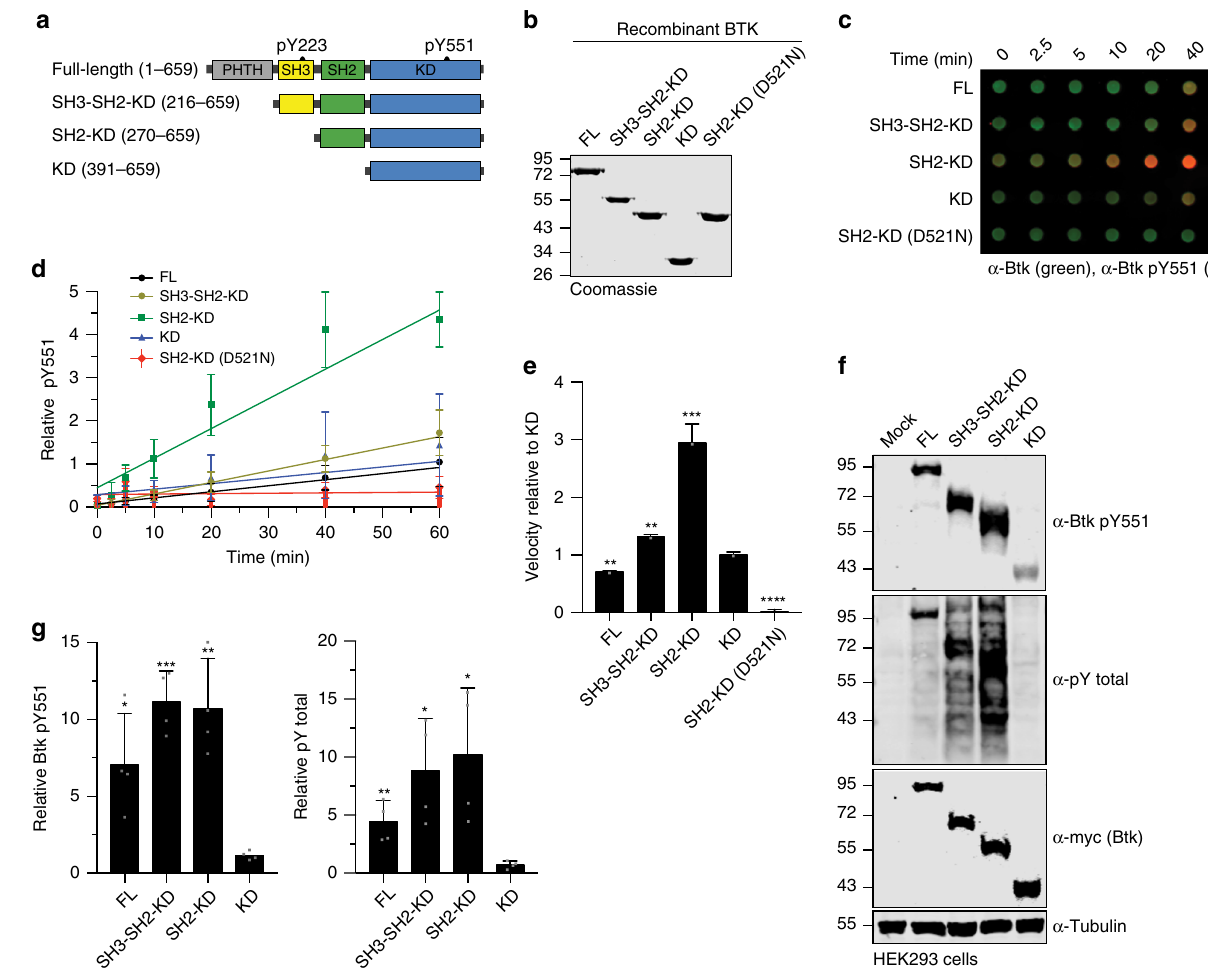
Fig. 2 Btk SH2 domain is critical for kinase activation. a Schematic representation of Btk constructs used in this study. Construct/domain boundaries and location of the key activating tyrosine phosphorylation sites (pY223 and pY551) are indicated. b Representative SDS-PAGE analysis of recombinant untagged Btk proteins puri fi ed from Sf9 cells. c In vitro autophosphorylation assay performed with recombinant Btk proteins at room temperature. The levels of pY551 (red channel) and total Btk (green channel) were assessed using immunoblotting in a dot blot apparatus. d Btk autophosphorylation kinetics shown in c normalized to total Btk signal and the calculated slopes of linear fi ts (relative velocities). Data are mean ± SD of at three independent experiments ( n = 3). e Relative velocities of Btk autophosphorylation relative to KD. Data are mean ± SD of three independent experiments ( n = 3) and P -values were calculated using an unpaired t -test. f HEK293 cells were transiently transfected with the indicated Btk constructs containing an N-terminal 6xMyc tag and kinase activation assessed by immunoblotting of cell lysates. g Quanti fi cation of pY551 and total pY shown in f normalized to total Btk (Myc) expression and relative to the KD. Data are mean ± SD of three biological replicates ( n = 4) and P -values were calculated using an unpaired t